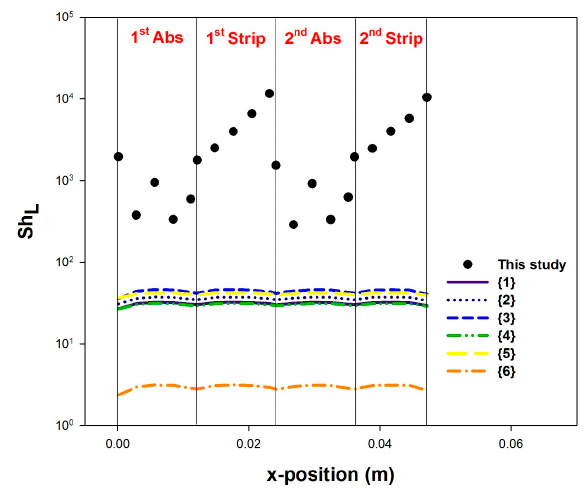
Figure 13. Liquid channel local Sherwood number of CS-HASMC (BC). Table 3. Mass transfer correlations for spacer-filled channels.